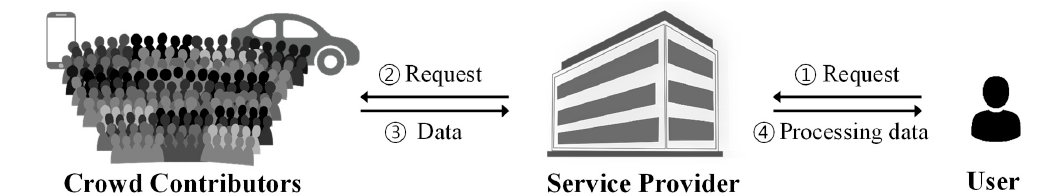
Figure 1. Structure of the crowdsensing